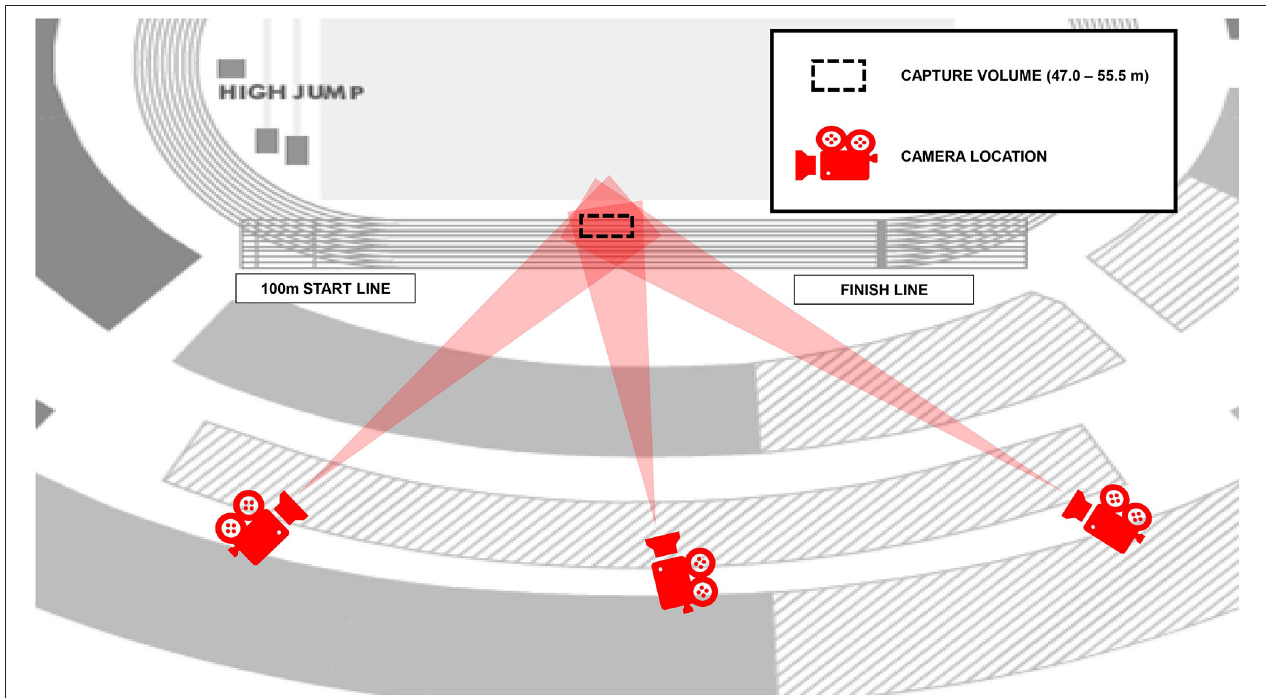
FIGURE 1 | Camera positions for recording the women’s 800m final (laps 1 and 2) at the 2017 IAAF World Championships. The position on the track where the athletes were recorded is shown by the dashed